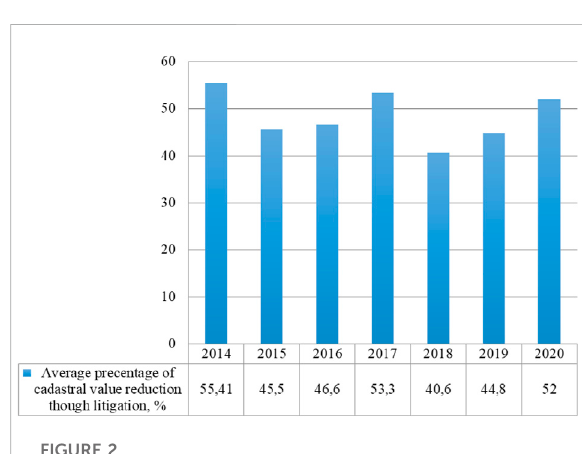
FIGURE 2 Statistics of changes in the cadastral value of land plots in court for the period from 2014 to 2020. Source (Authors ’